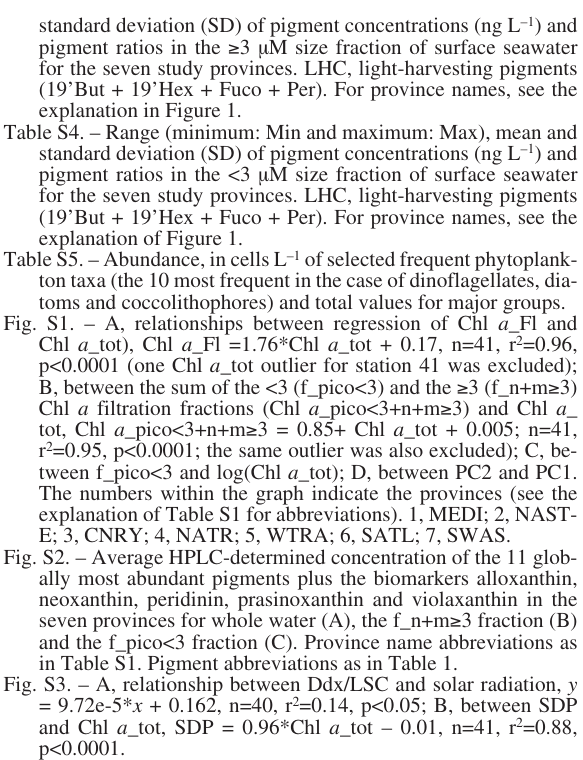
Fig. S8. – Geographic distribution of the ratio a (units are m –1 and mg m –3 , respectively). The lines indicate province limits, as in Figure